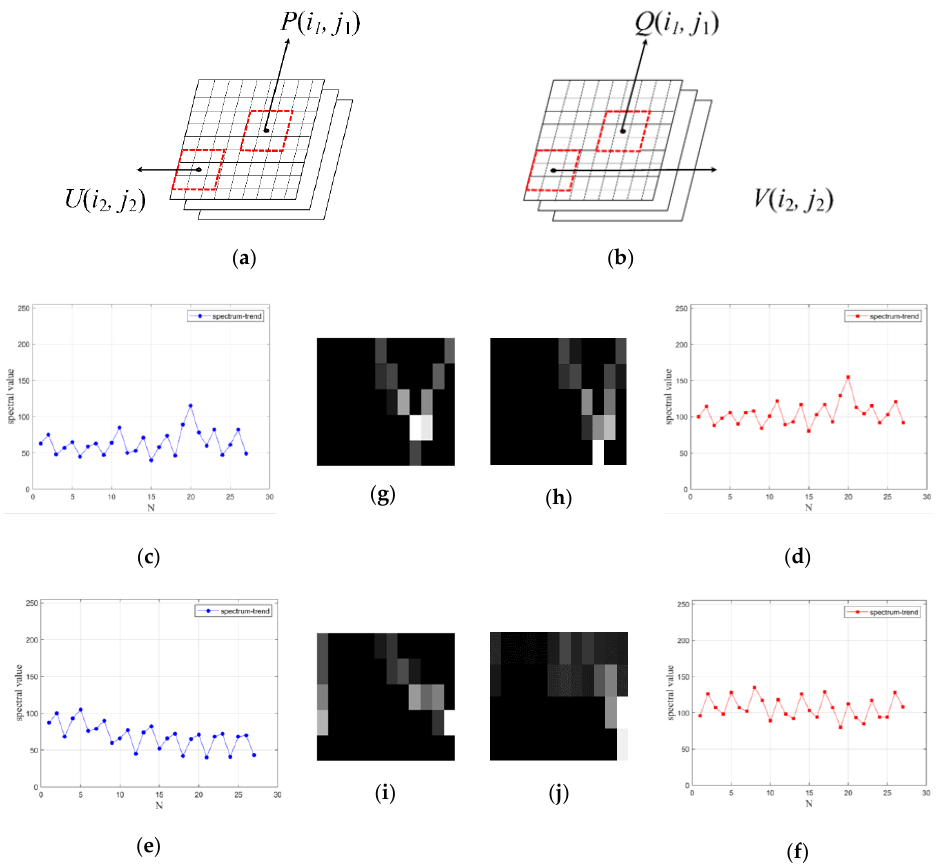
Figure 4. The illustration of local-scene spectrum-trend shape context (LSSC). ( a , b ) are images X 1 and X 2 , respectively. ( c – f ) are the spectrum-trend graphs generated by P ( i 1 , j 1 ), Q ( i 1 , j 1 ), U ( i 2 , j 2 ), and V ( i 2 , j 2 ), respectively. ( g – j ) use LSSC to describe the feature.